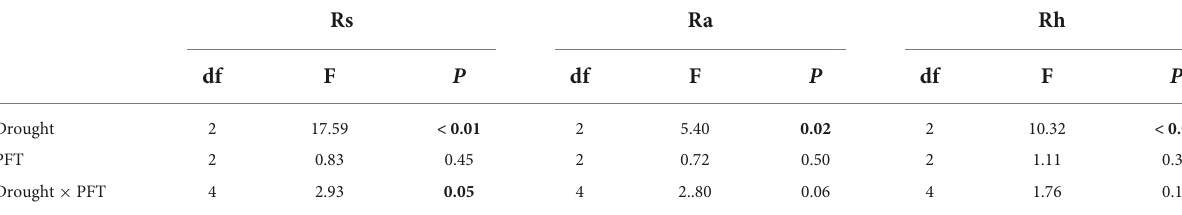
TABLE 2 Results of two-way ANOVA for the effects of droughts with seasonal timing, plant function types (PFTs), and their interaction on the sensitivity of soil respiration and its components. Rs Ra